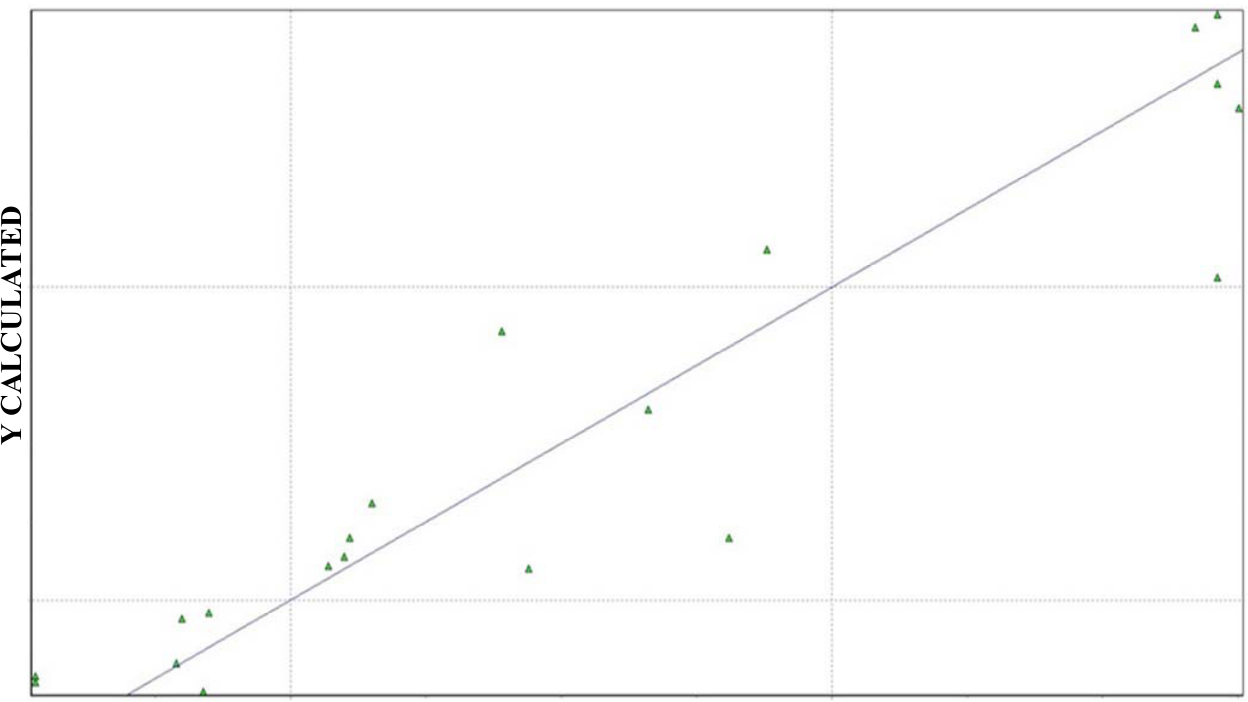
Figure 6. Graph of experimental versus calculated activity values, predicted by Equation (1).